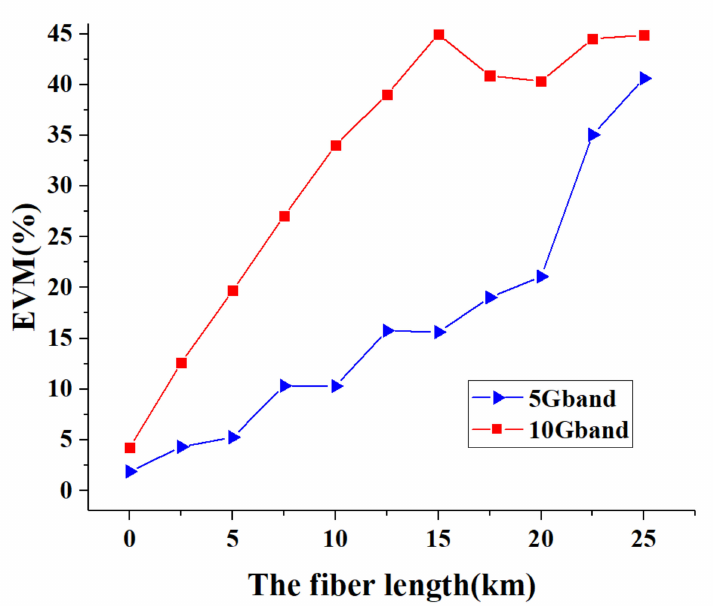
Figure 5. The measured EVM results versus the link fiber length.